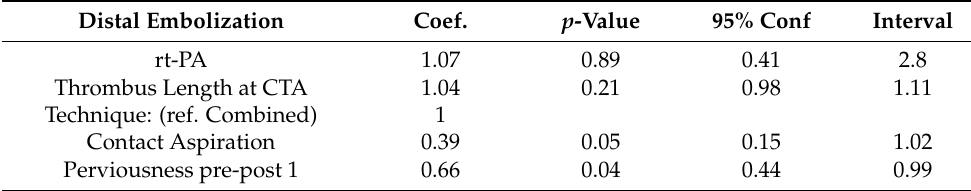
Table 2. Logistic regression. Distal Embolization